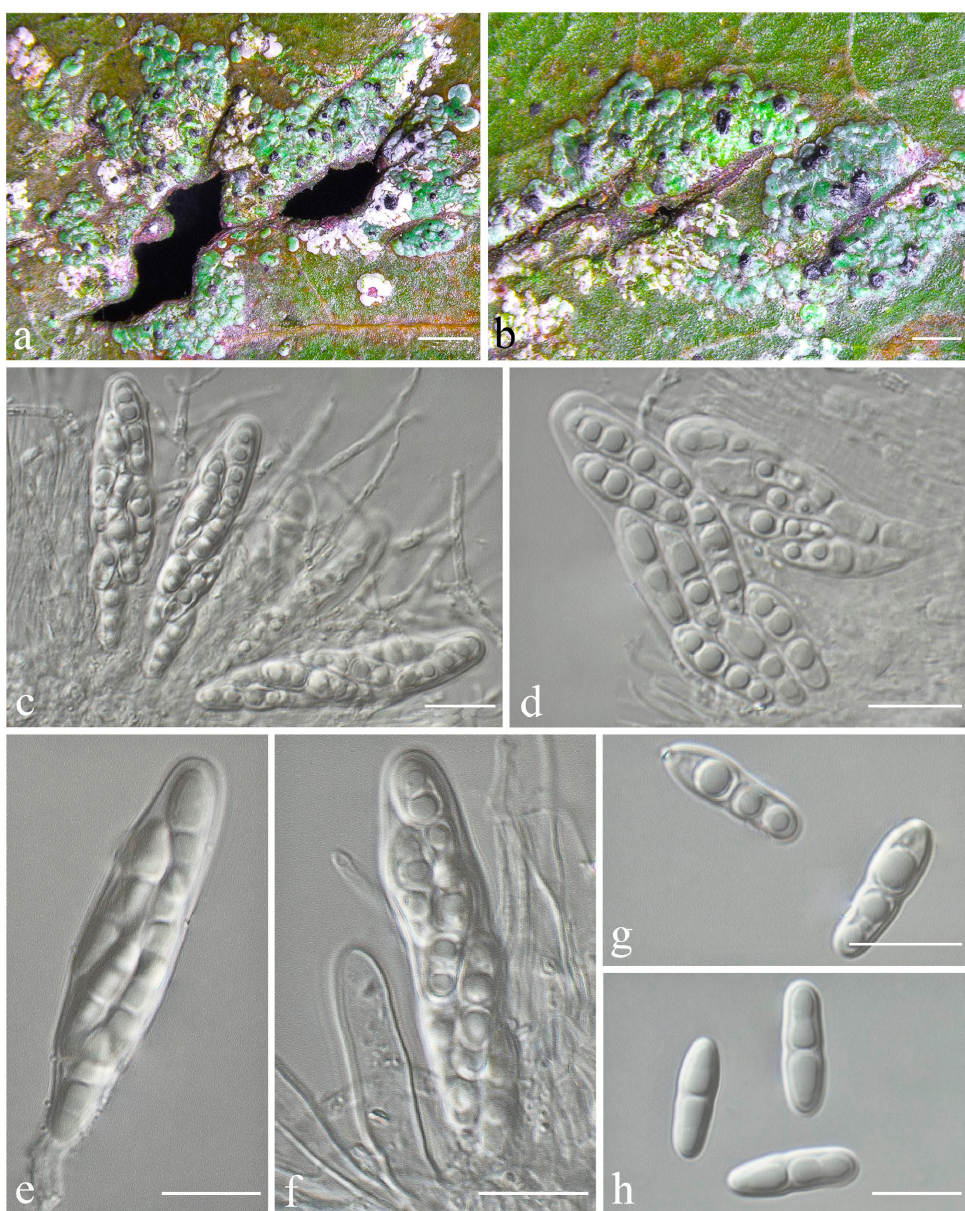
Figure 10. Strigula microcarpa sp. nov. (holotype, HMAS–L0139196). ( a , b ) Thallus; ( c – f ) asci and ascospores; ( g , h ) ascospores. Scale bars: ( a ) = 1000 μ m, ( b ) = 500 μ m, ( c – h ) = 10 μ m.